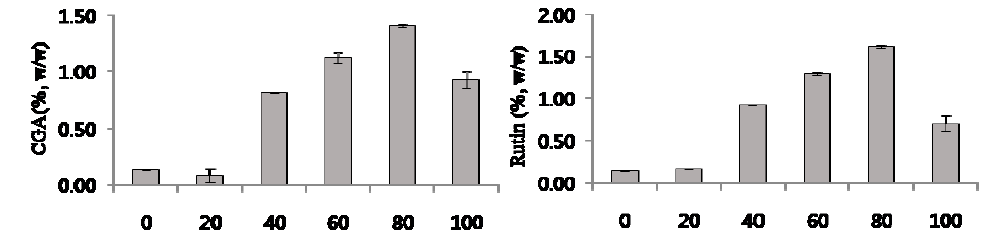
Figure 2. Content of chlorogenic acid (CGA) and rutin in ethanolic extracts from C. tricuspidata leaves; 0–100 on x -axis: 0–100% ethanolic extract. Each value was the mean ± SD ( n = 3).